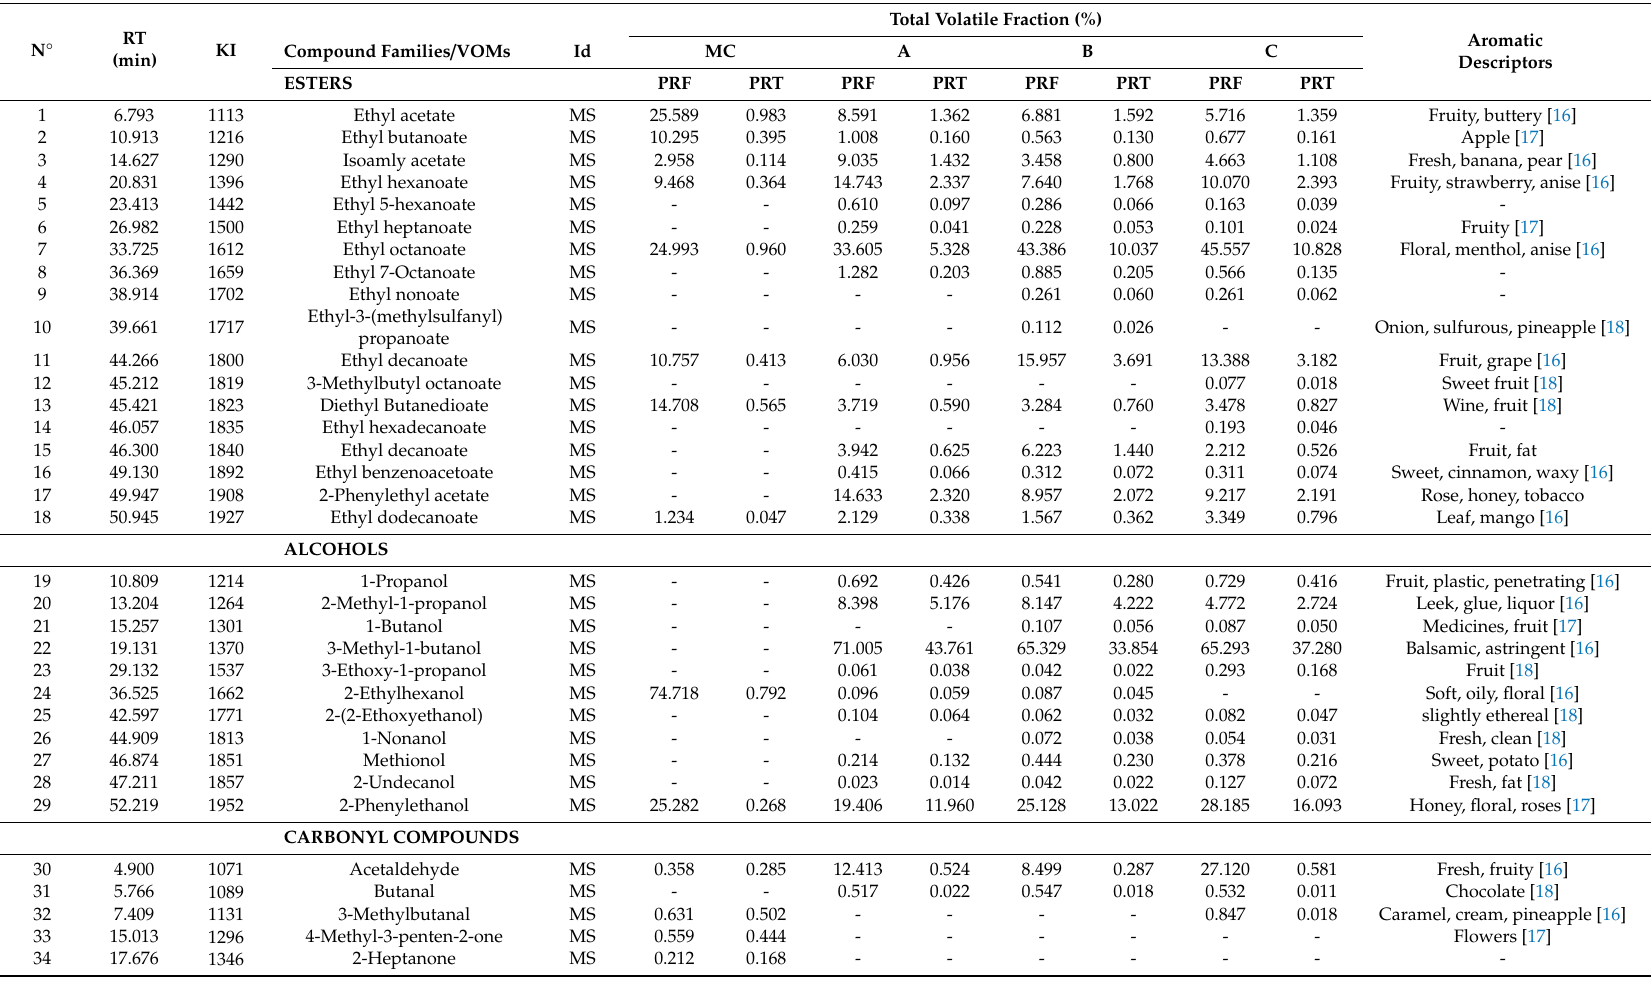
Table 3. VOMs identified by HS-SPME / GC-MS analysis, obtained from wines inoculated with pure strains (RFLP-mtDNA), indicating the contribution of each compound in the chemical family and in the total volatile fraction of the wine, as well as the olfactory